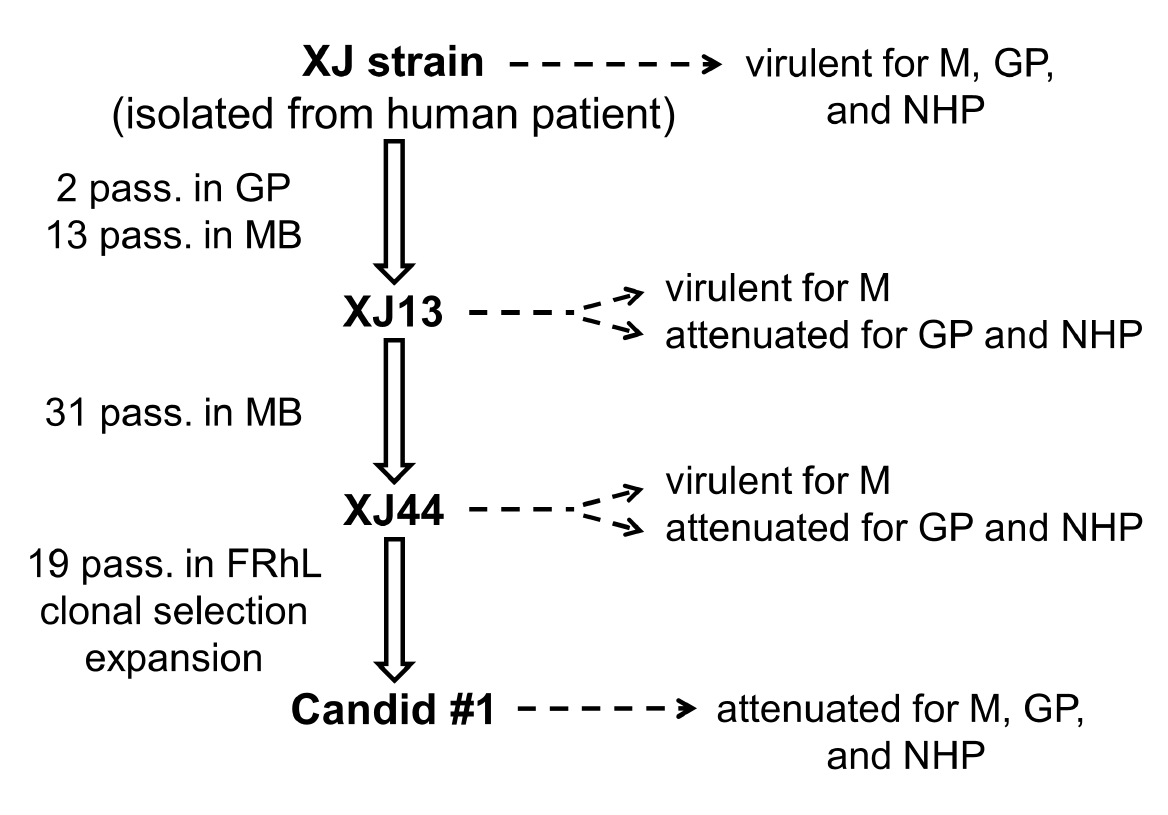
Figure 2. Development of Candid #1 vaccine strain of JUNV (adapted from Albarino et al ., 2011). M = mouse, MB = mouse brain, GP = guinea pig, NHP = non-human primate, FRhL = fetal rhesus monkey lung